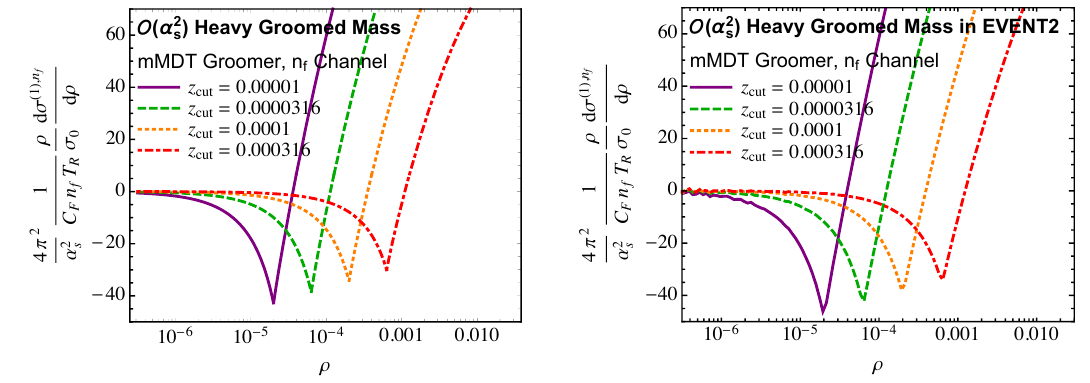
Figure 2 . Comparison between the prediction from eq. (4.19) (left) and EVENT2 (right) of the cusp region of the mMDT groomed heavy hemisphere mass in the n channel at next-to-leading f order for various values of z . The contribution in the ρ (cid:28) z 1 limit has been cut cut (cid:28)